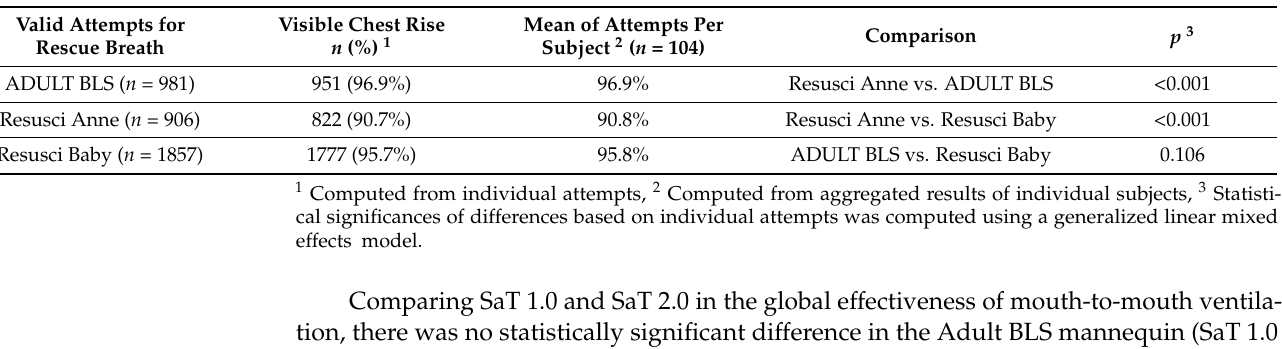
Table 1. Primary outcome—visible chest rise.